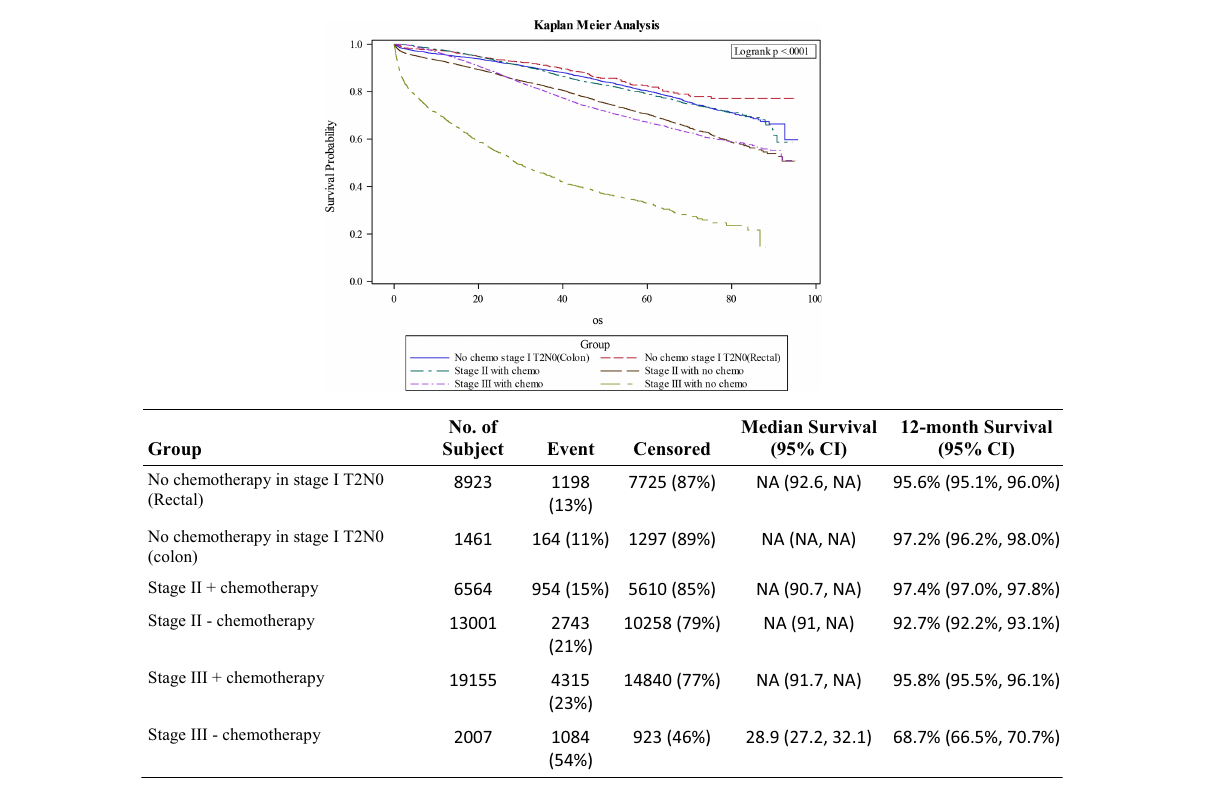
FIGURE 3 | Survival curves for stage I colon/rectal cancers, stage II CRC +/- adjuvant therapy and stage III after adjuvant